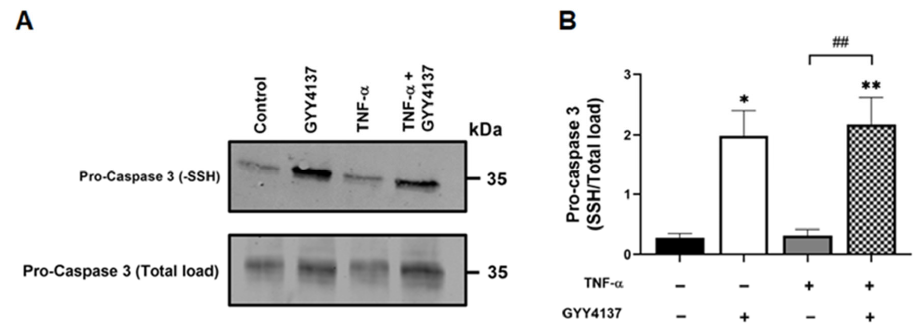
Figure 4. GYY4137 post-treatment mediates sulfhydration of pro-caspase 3. ( A ) Representative immunoblots of S-sulfhydrated and total load pro-caspase 3 protein expression in HUVECs. ( B ) Bar graph of S-sulfhydrated pro-caspase 3 (-SSH/Total load) quantified by ImageJ. p -values were cal- culated using one-way ANOVA test followed by Tukey’s comparison test. Data are shown as means ± SD; * p < 0.05, ** p < 0.01 vs. control, ## p < 0.01 vs. TNF- α -treated groups only. N = 3 independent experiments with 3 replicate in each